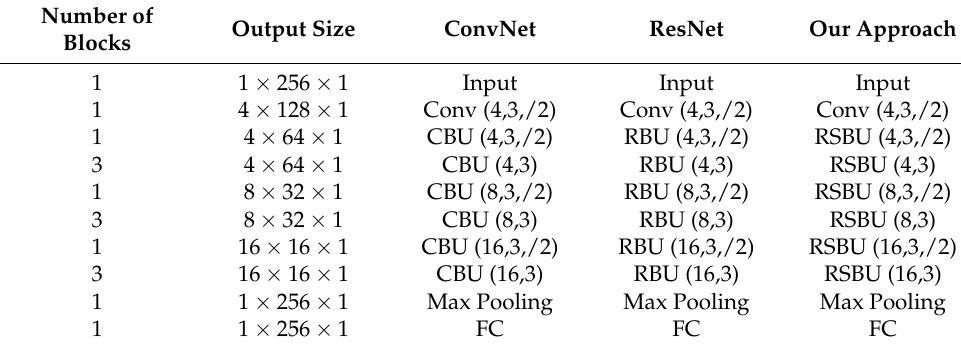
Table 2. Structural parameters of the models.